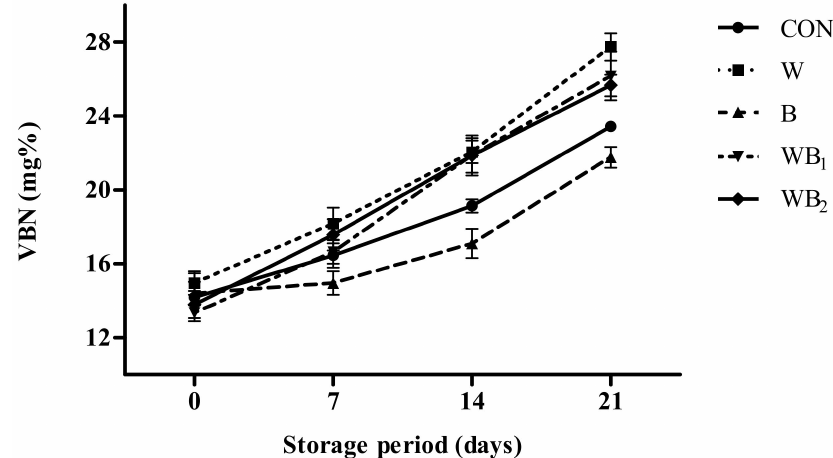
Figure 3. Changes in the volatile basic nitrogen (VBN) values of pork patties with di ff erent treatments during storage. Error bars indicate standard deviations. CON ( • ), control (no additive(s)); W ( (cid:4) ), addition of 2% whey powder; B ( (cid:78) ), addition of 0.5% B. serrata powder; WB 1 ( (cid:72) ), addition of 2% whey powder and 0.5% B. serrata powder; WB 2 ( (cid:7) ), addition of 2% whey powder and 1% B. serrata